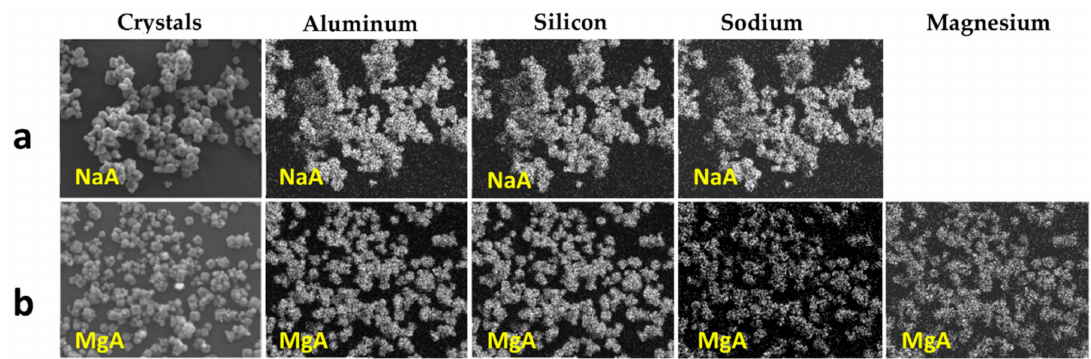
Figure 1. EDX mapping of aluminum, silicon, and sodium in ( a ) NaA and of aluminum, silicon, sodium, and magnesium in ( b ) MgA powder